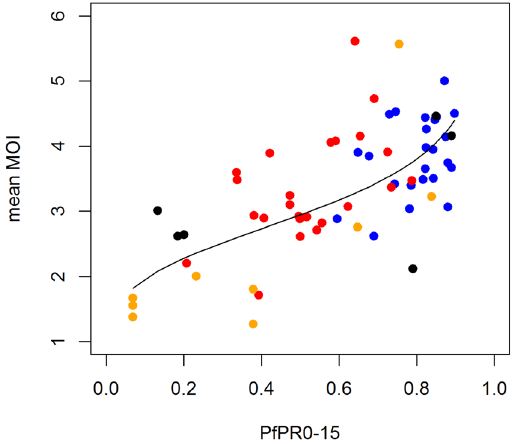
Figure 4. Relationship between slide-prevalence of infection in 0–15 year olds ( Pf PR0–15) and the mean multiplicity of infection (MOI) in infected individuals in 63 sites. Data (points) and model fit (black line). Data are: (blue) asymptomatic individuals in the test datset in Tanzania in 2004 and (red) 2007; 58 (orange) data from a previous review in multiple sites 43 containing both symptomatic and asymptomatic individuals; and (black) from symptomatic patients in Uganda 64 . 48 of the measures had simultaneous measures of slide-prevalence, while the other 15 were paired with an alternative measure of transmission intensity, the entomological inoculation rate (EIR, number of infectious bites per person per year). We converted the EIR values to slide-prevalence values in 0–15 year olds, using a previously published relationship 60 . Model fit (black line) is from linear regression of log MOI against the log odds of Pf PR0–15. The best fitting relationship is log MOI = 1.082 + 0.185 * logit( Pf PR0–15). This is further confirmed with a similar relationship fitted in a separate review and mathematical modelling paper published after our analysis was complete 65